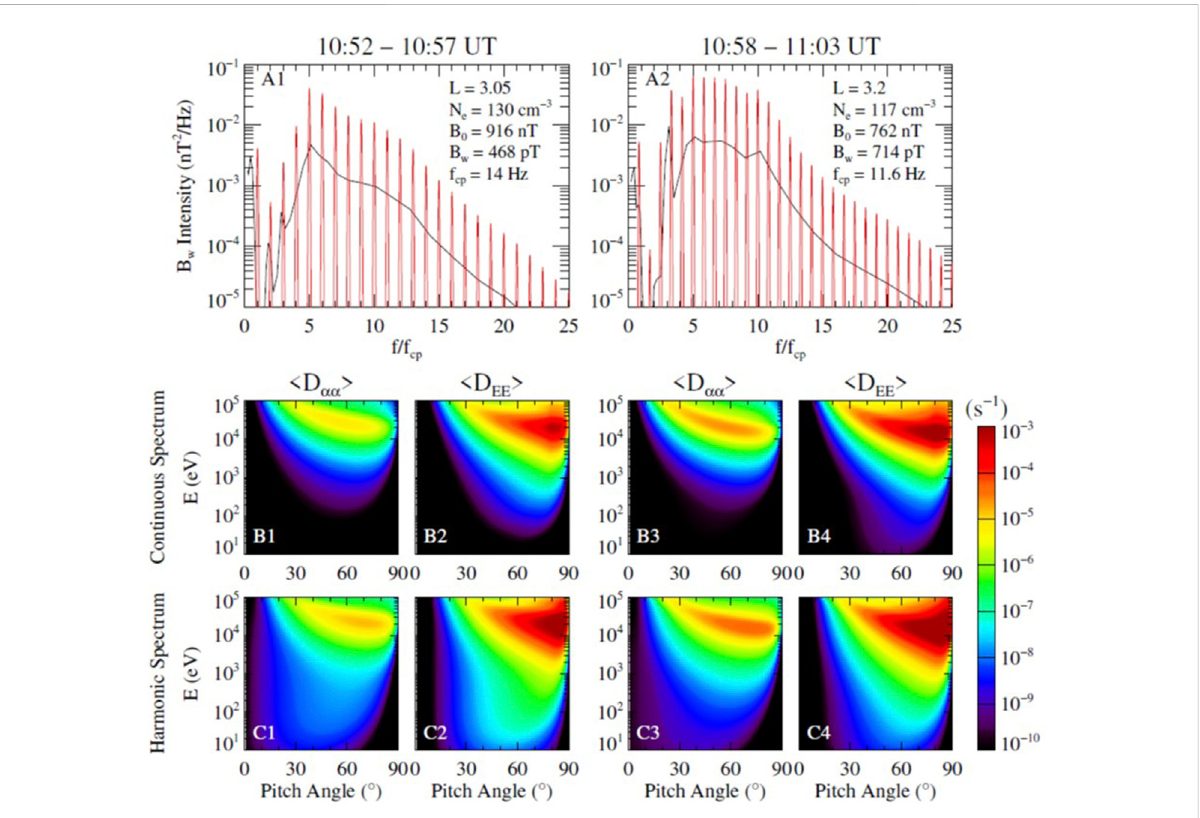
FIGURE 4 Quasi-linear analysisofMSwavesinteractingwithprotonsduringtwoadjacenttimeintervals.Blacktracesin (A1,A2) aretheobservedmagnetic power spectraldensities (PSDs) ofMSwaves.Corresponding assumed harmonic PSDs (red)are overplotted. Panels (B1,B2) show thepitch angle and momentumdiffusioncoef fi cientsderivedfromthecontinuousPSDshowninA1.Correspondingdiffusioncoef fi cientsderivedfromthediscretePSD are shown in panels (C1,C2) . Same format is followed for (B3,B4) , (C3,C4) for the PSDs in